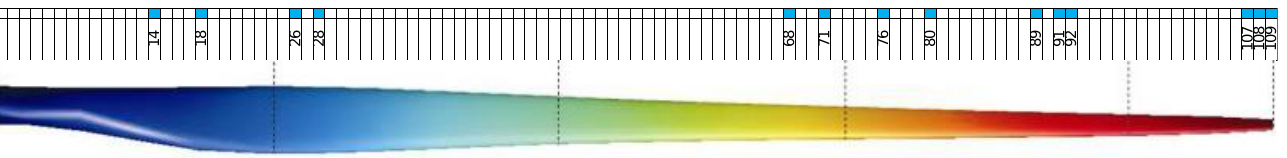
Figure 6. Graph presenting numbers of randomly selected ribs of the best individual for optimization process